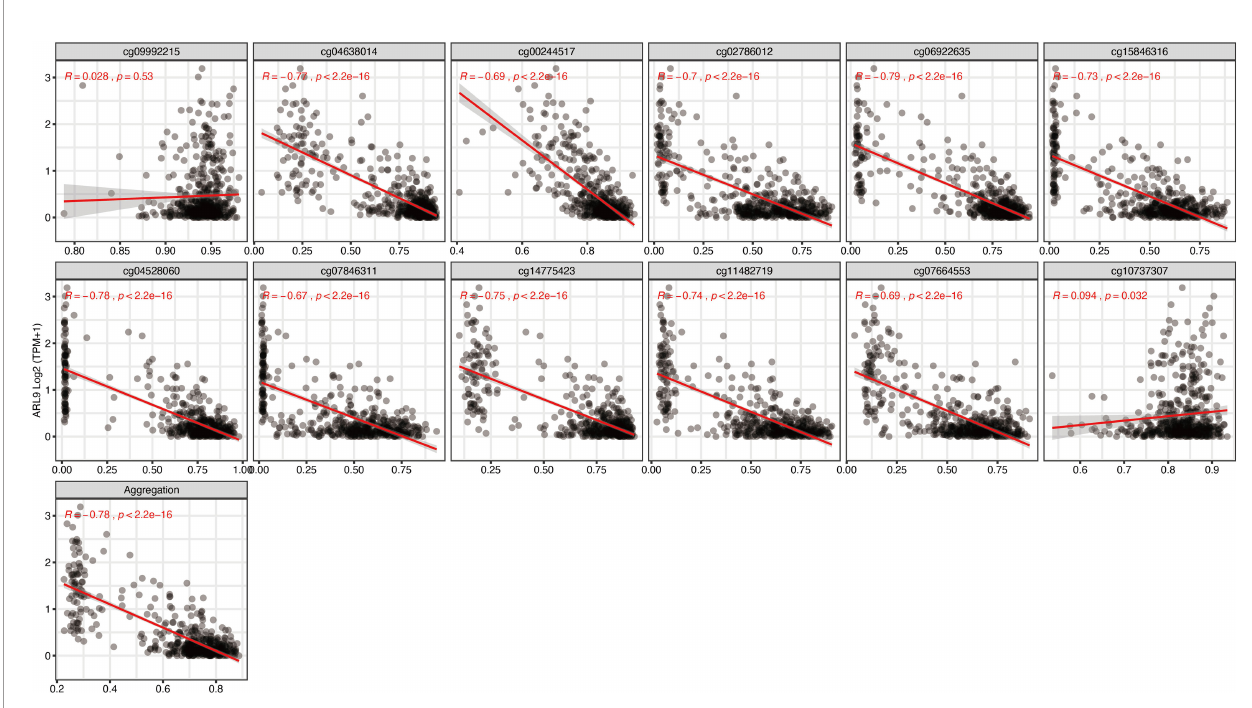
FIGURE 2 | Regression analysis involving each speci fi c CpG site and aggregated levels, and the expression of ARL9 in the whole dataset from